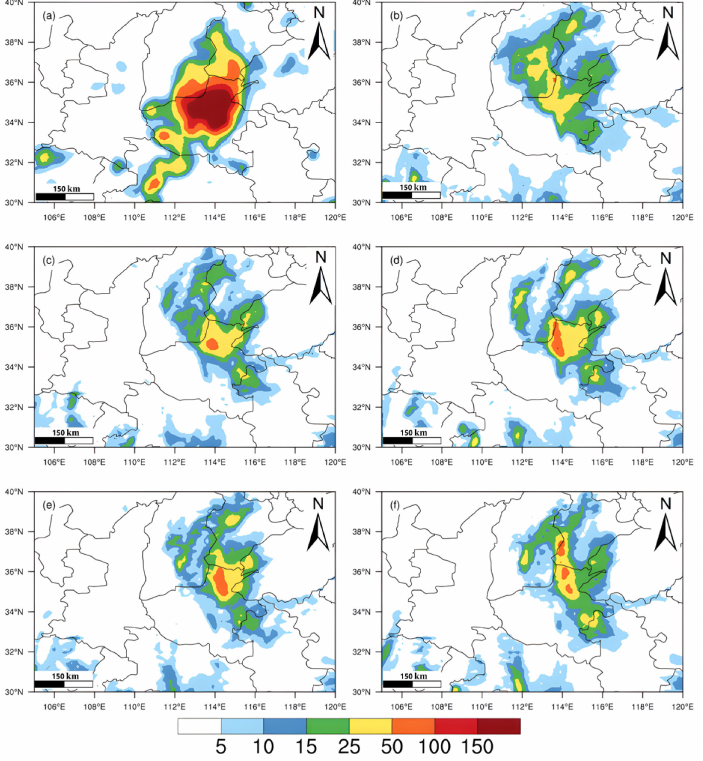
Figure 8. The 24 h cumulative rainfall (unit: mm) from 00:00 to 23:00 on 20 July with a model start time of 00:00 on the 18th: ( a ) measured rainfall, ( b ) exp0, ( c ) exp1, ( d ) exp2, ( e ) exp3, and ( f )